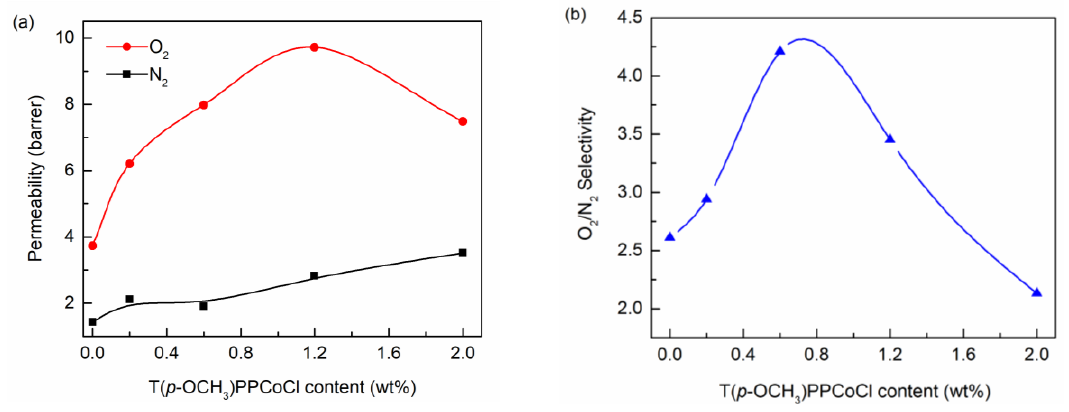
Figure 6. E ff ect of T( p -OCH 3 )PPCoCl content on gas permeability ( a ) and O 2 / N 2 selectivity ( b Figure 6. Effect of T( p -OCH 3 )PPCoCl content on gas permeability ( a ) and O 2 /N 2 selectivity ( b ).